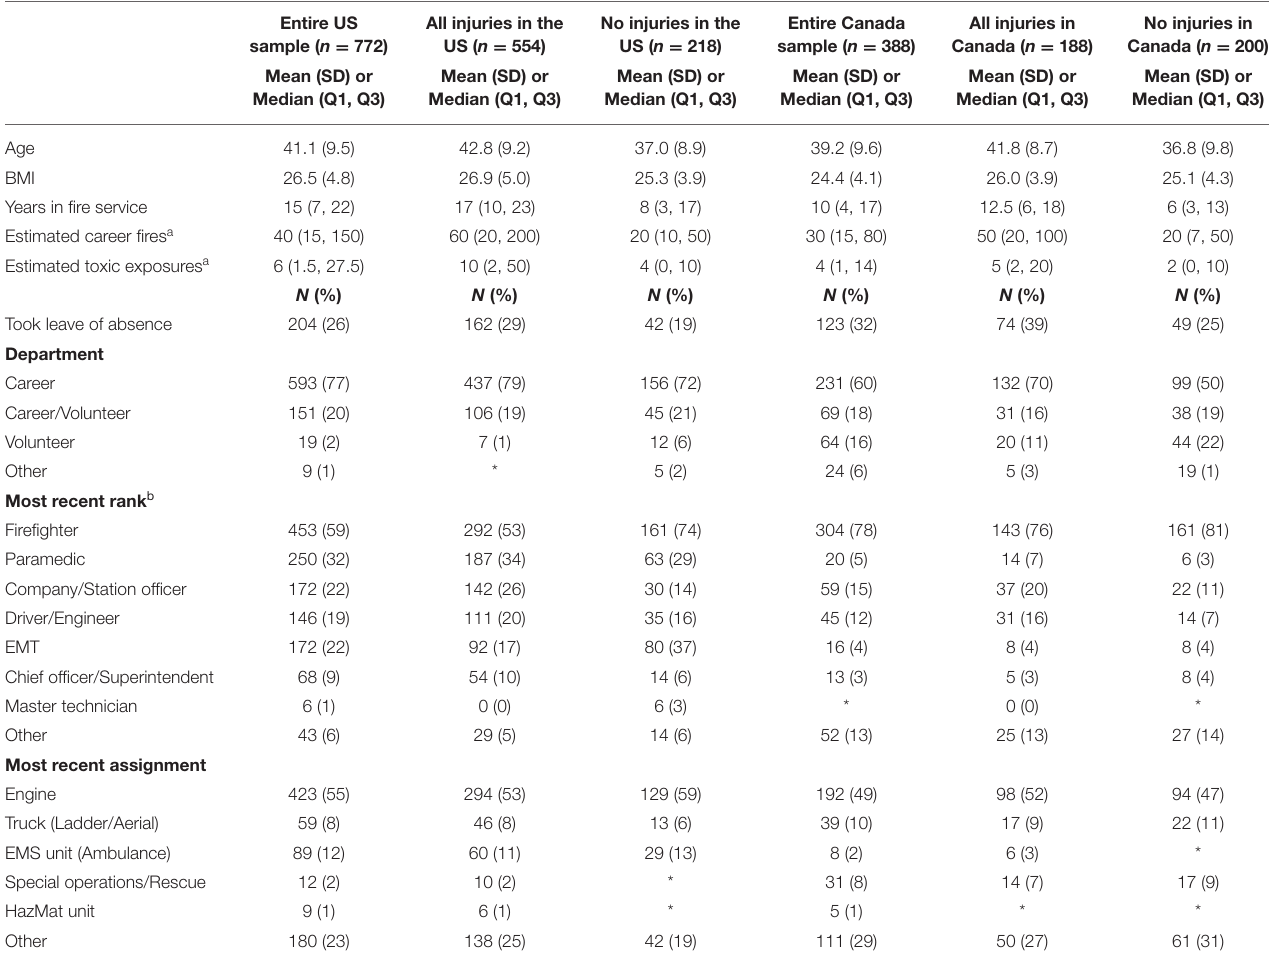
TABLE 3 | Firefighting experience of active female firefighter survey respondents in the US and Canada, by country and injury